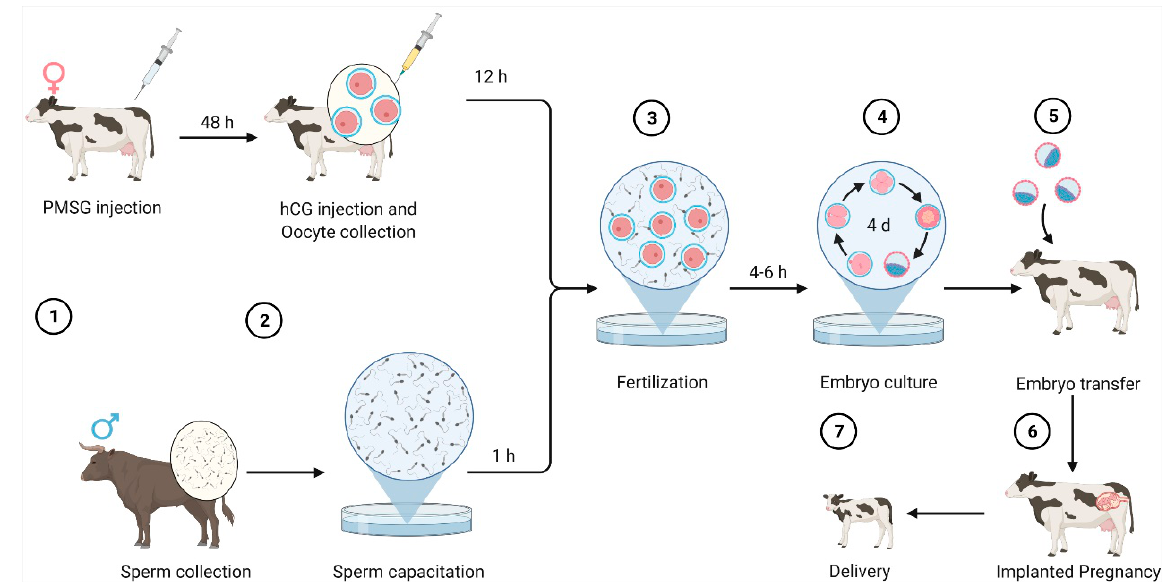
Figure 1. In vitro fertilization in cows and delivery, shown as steps (1) to (7). Figure created with Biorender.